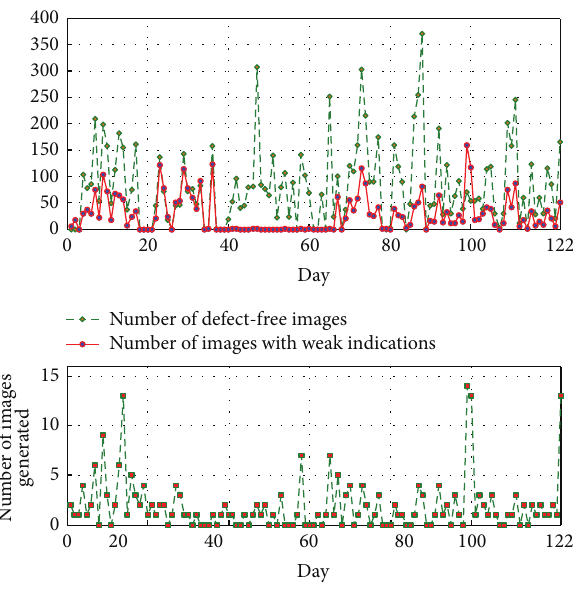
Figure 5: Distribution of the number of images generated by day for each category.